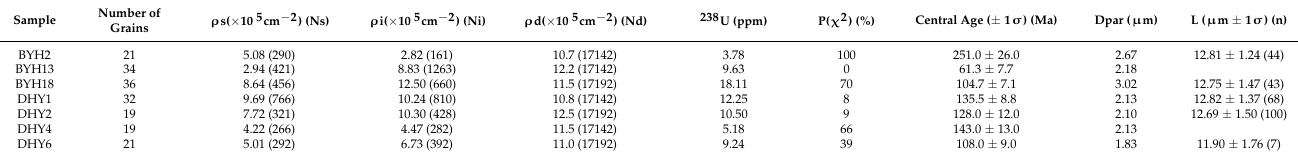
Table 2. Apatite fission-track data. ρ s and ρ i, spontaneous and induced track densities; ρ d, dosimeter track densities; 238 U, concentration of 238 U; P( χ 2 ) (%), chi-square probability, P( χ 2 ) ≥ 5% indicate a homogenous population [39]; D par , the mean length of fission-track etch pit; L, the mean track length with c-axis projection; and n, number of lengths measured. Ages were calculated using the Radial Plotter program in [38], using a zeta value of 265.8 ±